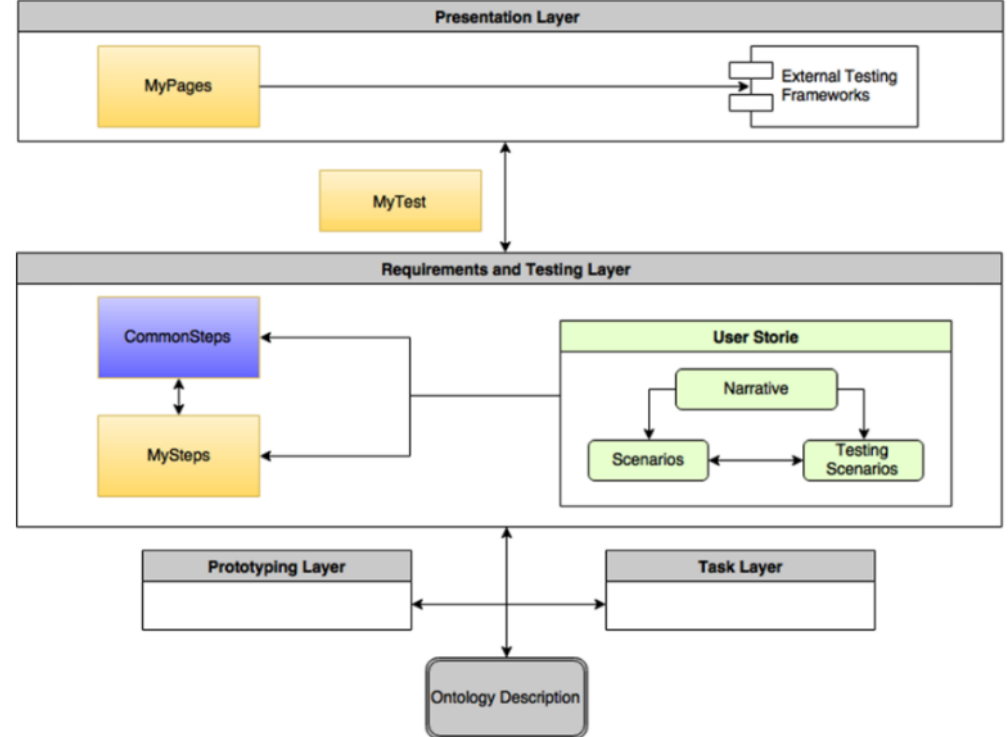
Figure 27. Architectural representation of automated testing in the Final UI